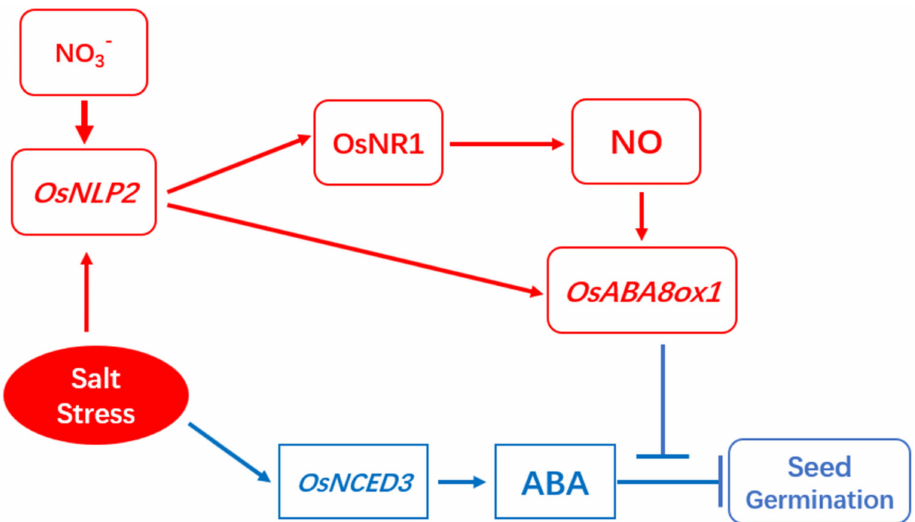
Figure 9. A simplified model of OsNLP2-NR module promotes seed germination under salt stress. Seed germination was significantly reduced by salt stress by promoting ABA biosynthesis and ROS accumulation. To cope with this problem, rice seed has elevated the expression of OsNLP2 which is also activated by nitrate. The activated OsNLP2 thereby promote the expression of both OsABA8ox1 and OsNR1/2, resulting in an enhanced ABA catabolism and accumulation of NO